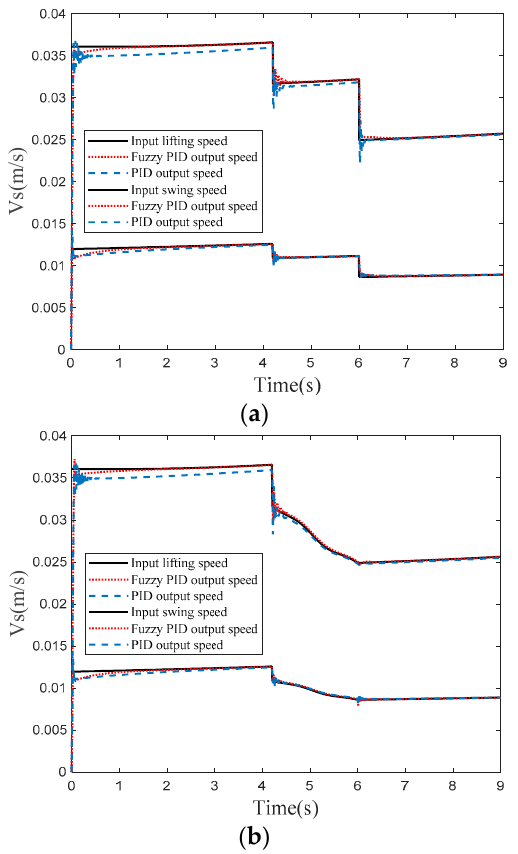
Figure 13. Speed response curves under different signals: ( a ) step signal response and ( b ) ramp signal response.